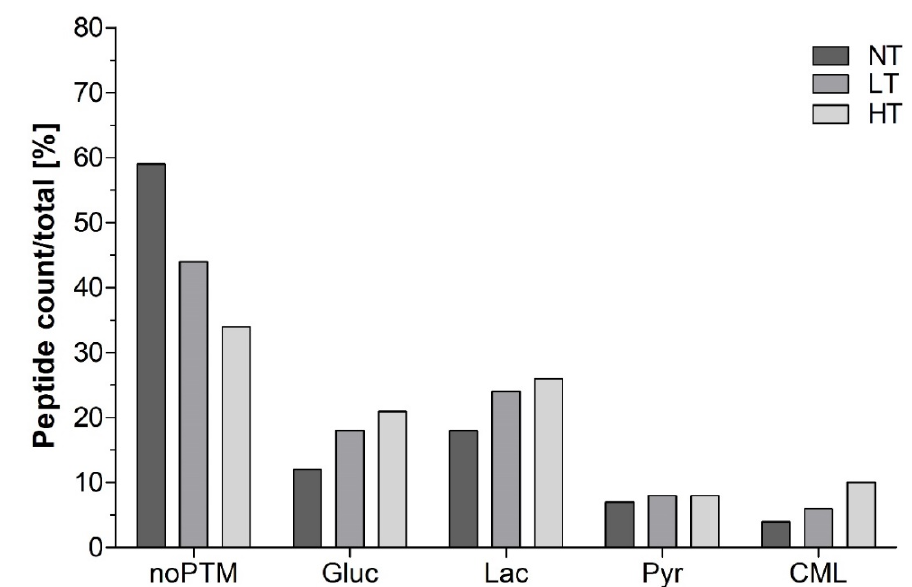
Figure 5. Digestion-derived peptides identified on the basolateral side of Caco-2 cells exposed to in vitro digests of cow’s milk protein, non-treated (NT), heated in the presence of lactose at low temperature (LT), and high temperature (HT). Peptides without posttranslational modification (noPTM), as well as modification to glucosyl lysine (Gluc), lactosyl lysine (Lac), pyrroline (Pyr), and carboxymethyl lysine (CML) are shown expressed as peptide count relative to the total number (NT: 181, LT: 129, HT: 121) of peptides in one sample.